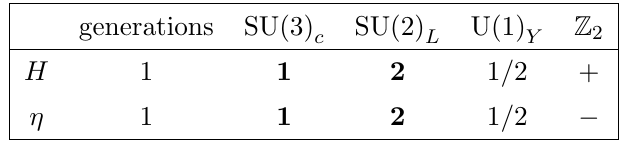
scalar doublets (cid:8) 1 and (cid:8) 2 . L